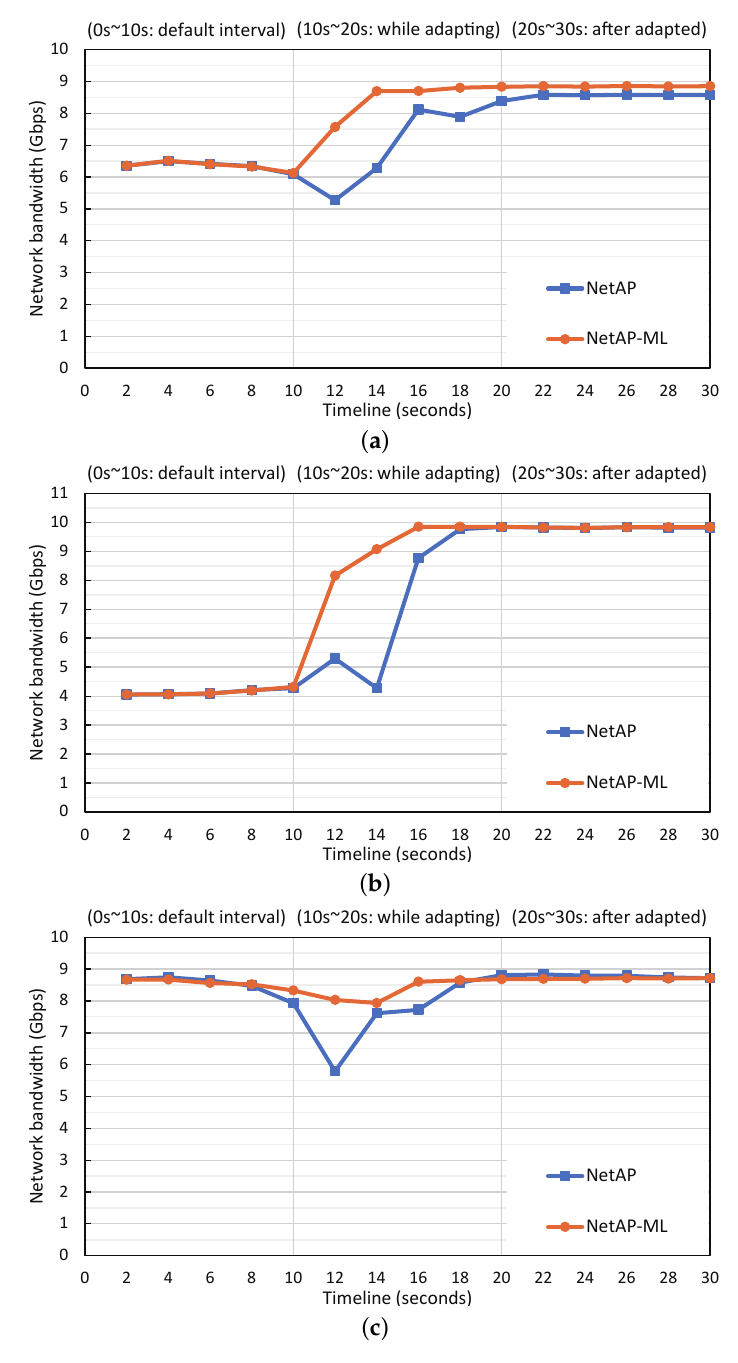
Figure 4. Performance changes during and after adaptation of NetAP and NetAP-ML. ( a ) 3 VMs, 2 threads, and 128 B message size. ( b ) 2 VMs, 5 threads, and 96 B message size. ( c ) 4 VMs, 1 thread, and 192 B message